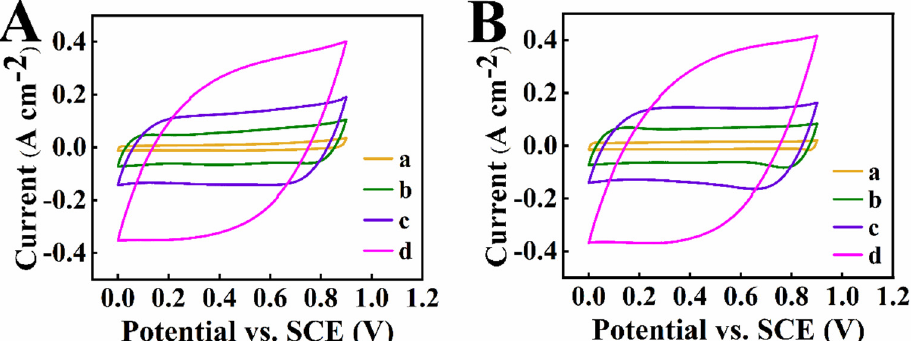
Figure 6. CVs for electrode prepared by Method 2 for ( A ) TP 1 and ( B ) TP 3 for scan rates of (a) 2, (b) 10, (c) 20, and (d) 50 mV s − 1 .